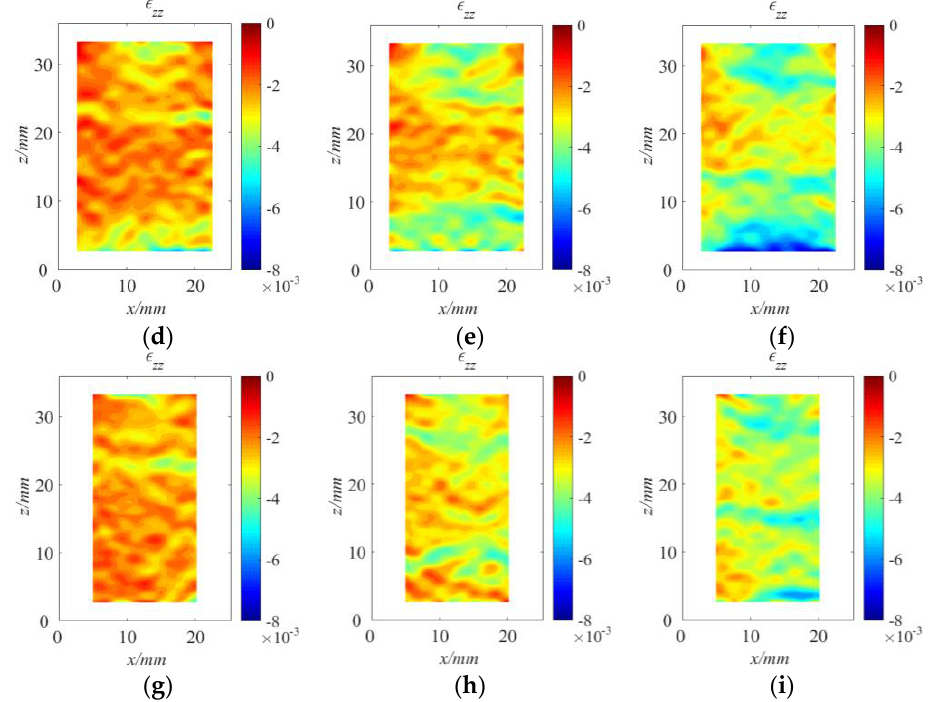
Figure 6. Contour plots of ε zz strain fields of the sectional images in step 4, step 5 and step 6. ( a – c ) along y = 6.20 mm, respectively; ( d – f ) along y = 12.50 mm, respectively; ( g – i ) along y = 18.80 mm, respectively.